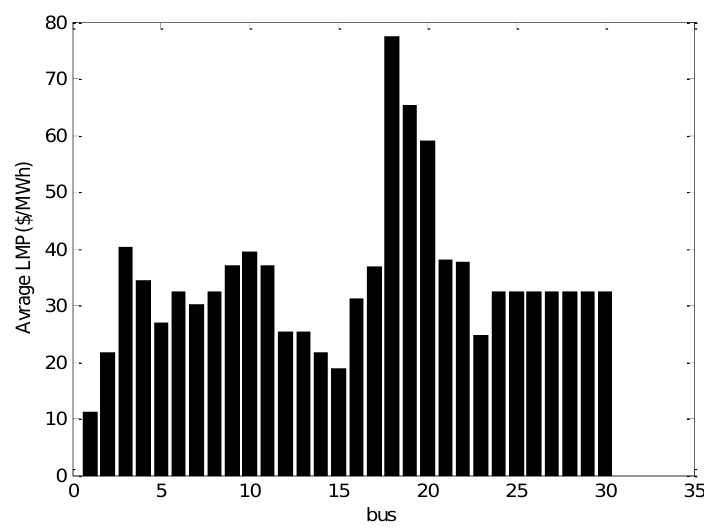
Figure 13. The average LMP for different buses — 24 h ahead.